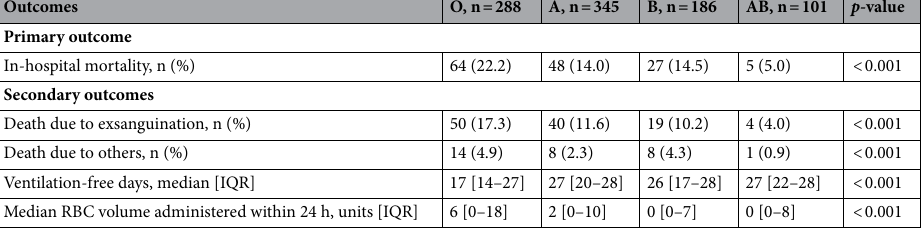
Table 2. Outcomes of patients categorized by blood type. Categorical variables are expressed as numbers (%), continuous variables are presented as medians (25th–75th percentiles). IQR interquartile range, RBC red blood